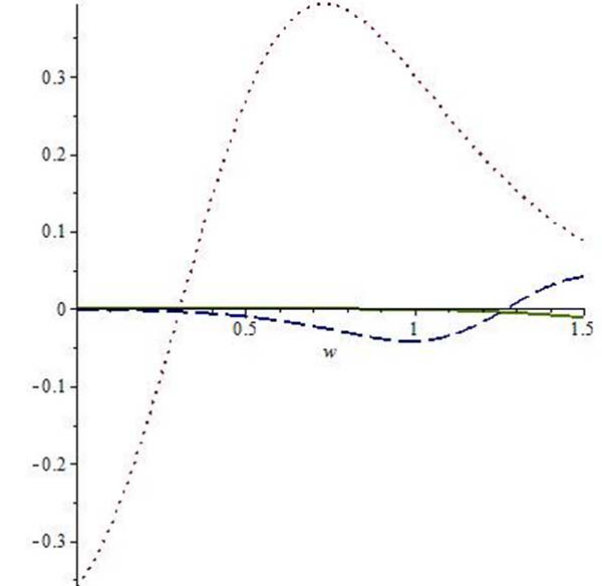
Figure 2. Error obtained with (cid:1834)(cid:4666)(cid:1875)(cid:4667) when (cid:1858) ≡ (cid:3398)1 and ϵ = 0.5, 0.25 and